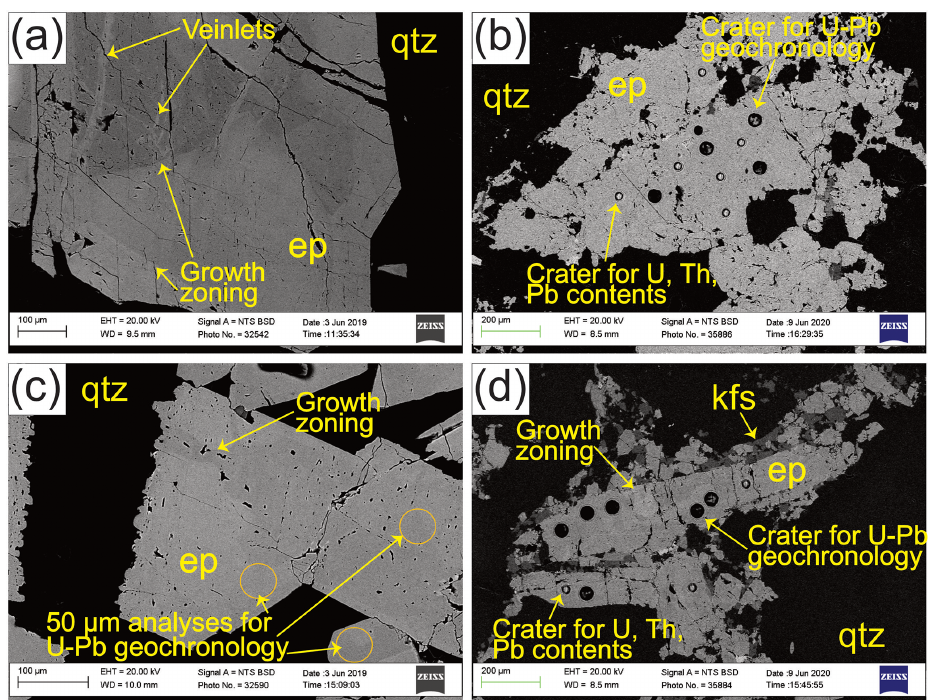
Figure 2. BSE images of (a) Albula-1, (b) Grimsel-1, (c) Grimsel-2, and (d) Heyuan-1 epidote. The specific epidote grain shown in panel (a) was not analyzed. The locations of the BSE images are indicated by the green rectangles in Fig. 1. bt: biotite; chl: chlorite; ep: epidote; kfs: K-feldspar; plg: plagioclase; qtz: